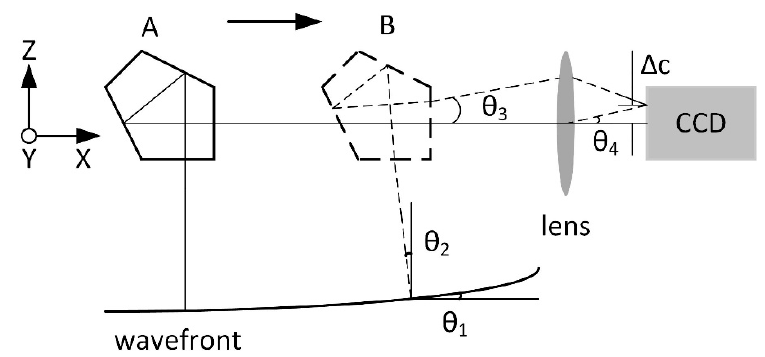
Figure 1. Pentaprism scanning schematic diagram. CCD: charge-coupled device.